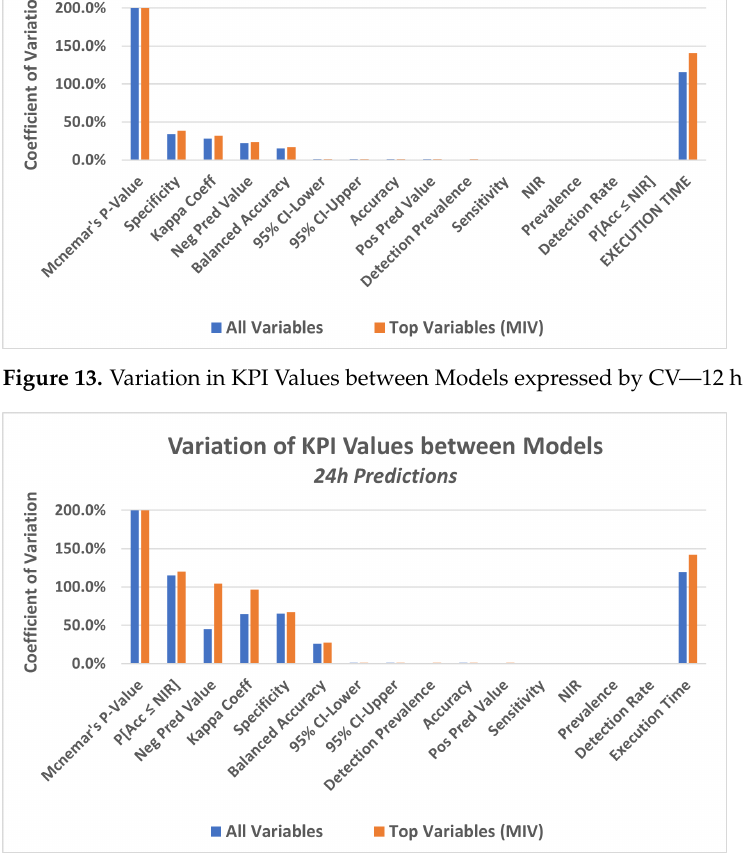
Figure 14. Variation in KPI Values between Models expressed by CV—24 h Predictions.